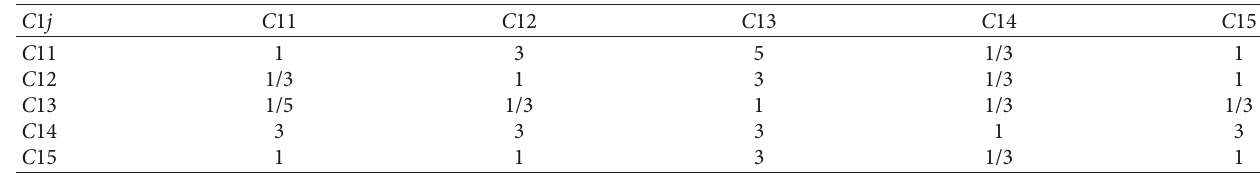
Table 5: Judgment matrix of C 1 j .